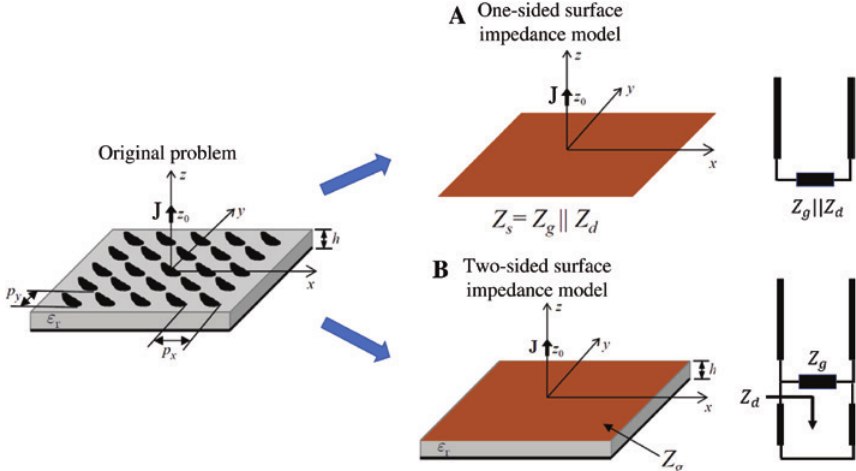
Figure 3: Modeling of metasurfaces in terms of surface-impedance sheets. Left: Original problem of a metasurface (planar array of meta-atoms) in a host structure (in this example, a grounded slab). Right: Two models in terms of surface-impedance sheets based on different forms of boundary conditions, as discussed in the text: (A) one-sided surface-impedance model and (B) two-sided surface-impedance model, with the corresponding transmission-line representation shown on the right (thick lines represent transmission-line segments and black boxes indicate lumped impedances). A generic point sources is depicted above the metasurface. Adapted with permission from Ref.